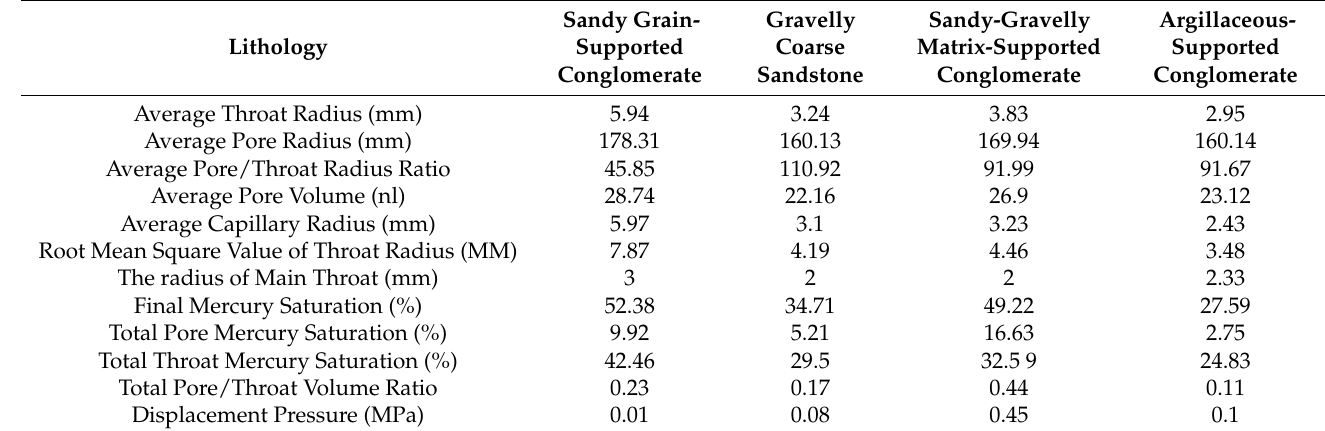
Table 3. Microscopic pore structure parameters of core samples with different lithologies.